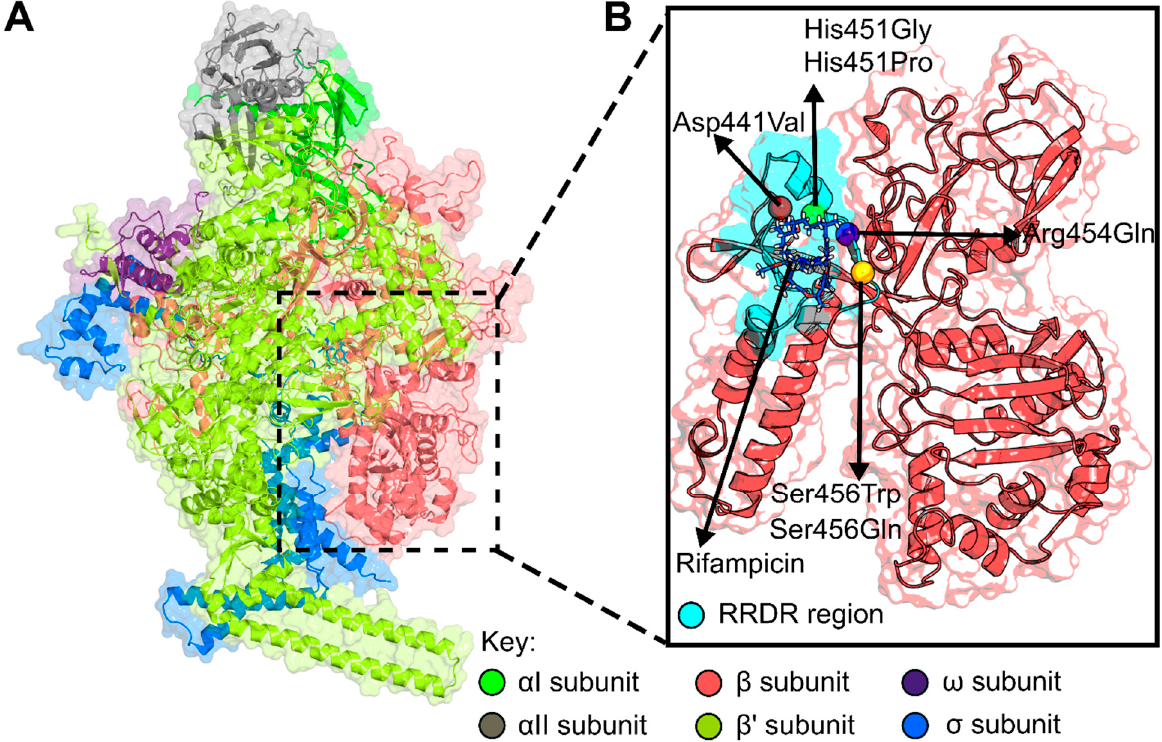
Figure 1. ( A ) Structural representation of the multiunit M. Tuberculosis RNAP catalytic core complex (consisting of α I , α II , β , β′ , ω subunits) bound to an σ initiation factor to form a holoenzyme, PDB ID: 5UHC [33,34]. ( B ) Focused image of mutations under investigation (shown as spheres) within the rpoB model (residues 160 to 600). The RRDR region is mapped on the structure and colored cyan. RIF is shown as sticks and colored blue.